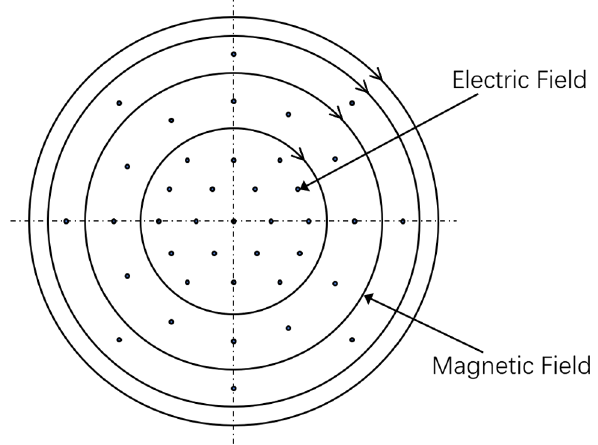
FIG. 1. Electromagnetic fields of the monopole